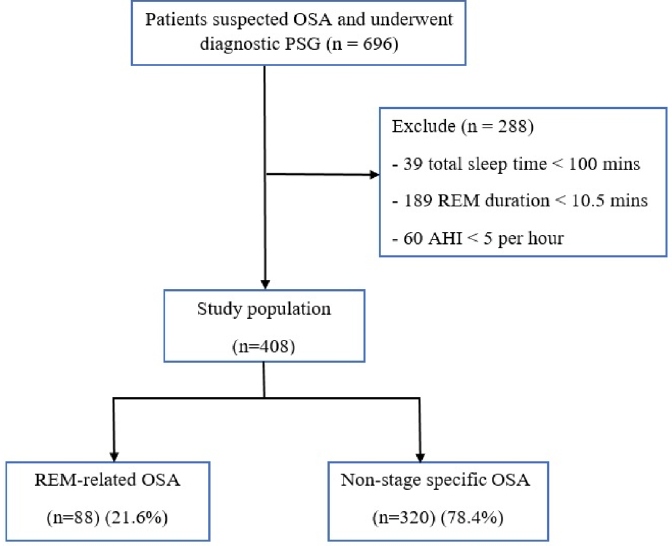
Figure 1. Study population flow chart. OSA obstructive sleep apnea, PSG polysomnography, AHI apnea– hypopnea index, REM rapid eye